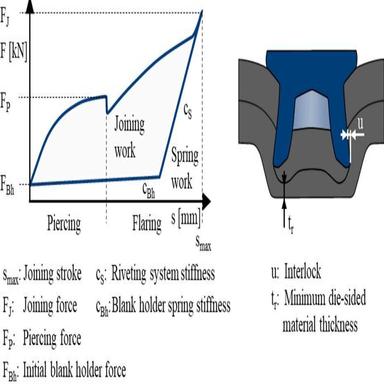
Typical force-stroke curve of a riveting process with parameters and characteristic joint parameters in the cross-section.